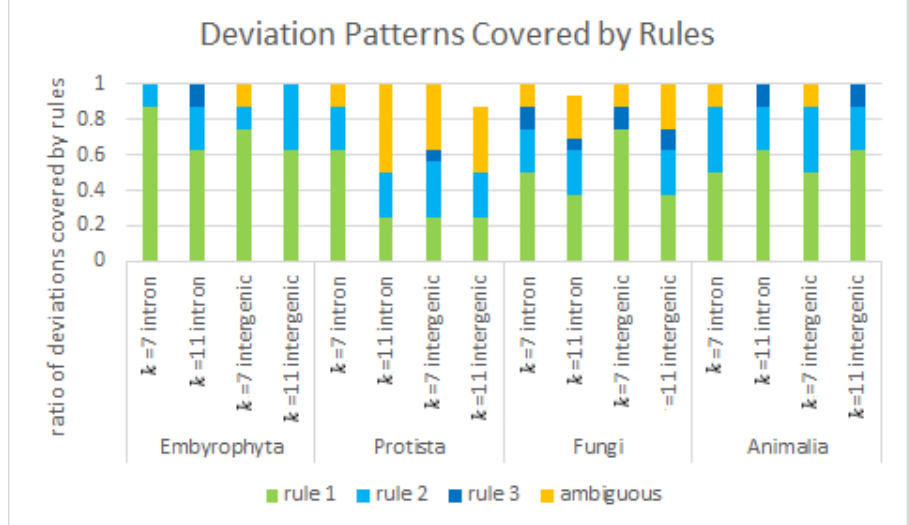
Figure 6. Deviation patterns covered by rules. The coverage ratios by the rules and ambiguous value sets in all four kingdoms for introns and intergenic regions for k = 7 and k = 11 are given.